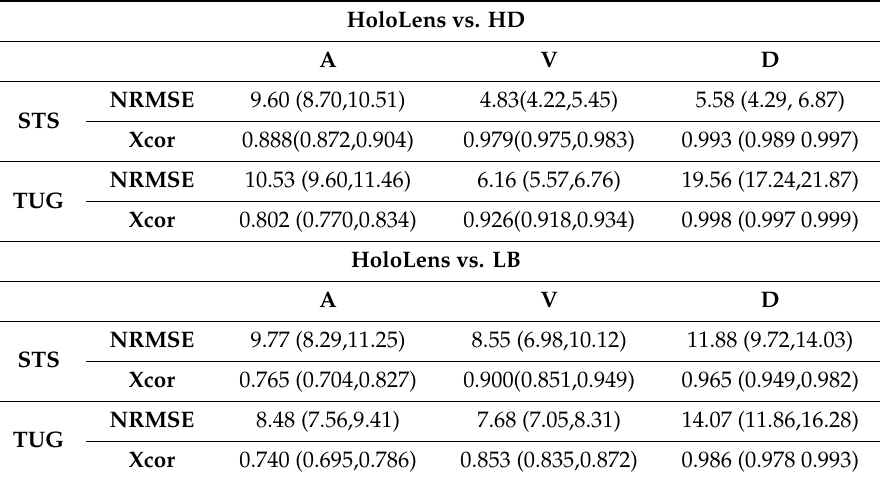
Table 2. Kinematic measurement (VT acceleration, velocity, and displacement) agreement between the HoloLens and HD / LB sensors. NRMSE-Normalized Root Mean Squared Error. Xcor-Cross Correlation Coe ffi cient. All values reported as the mean and 95% confidence interval.